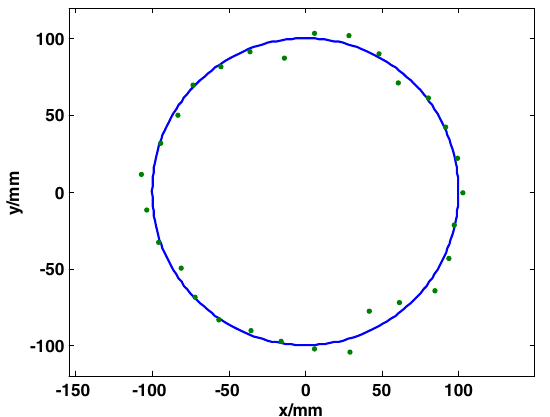
Fig. 2. Null space data generation for a least squares circle fit, simulating a three-lobed form error.